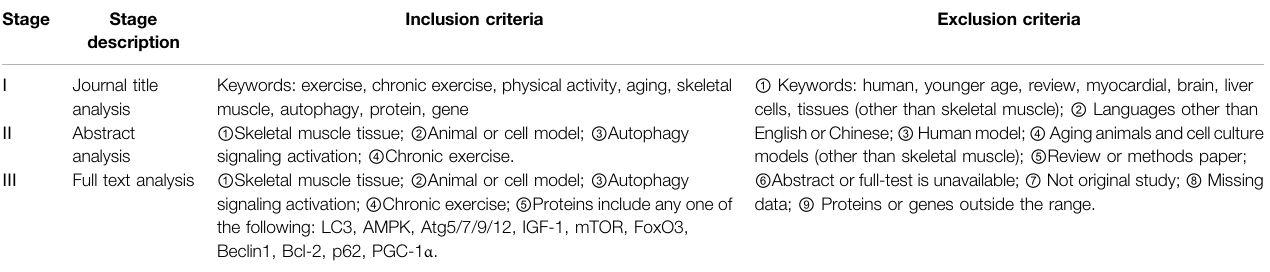
TABLE 1 | Inclusion and exclusion criteria. At each stage of the research analysis for inclusion review, papers were included and excluded according to the above